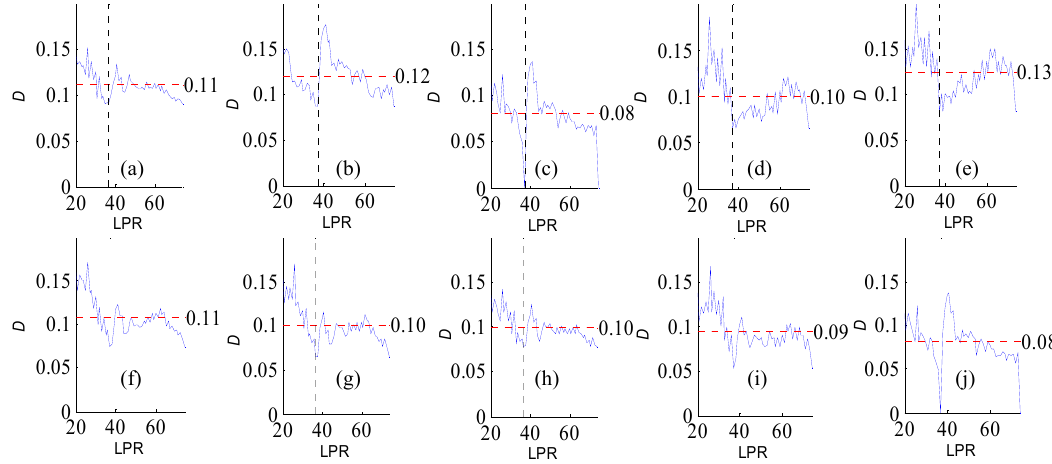
Figure A26. Variation of flow regime alteration degree (D) measured by the RVA with change in the length of post-impact flow time series (LPR) under a periodicity of 37 years. ( a – j ) correspond to pre-impact flow time series length = 26, 32, 37, 42, 48, 53, 58, 63, 69, and 74 years, respectively. The abscissa value for the vertical dotted line is 37. The ordinate value for the horizontal dotted line is the mean degree of flow regime alteration in each subfigure.